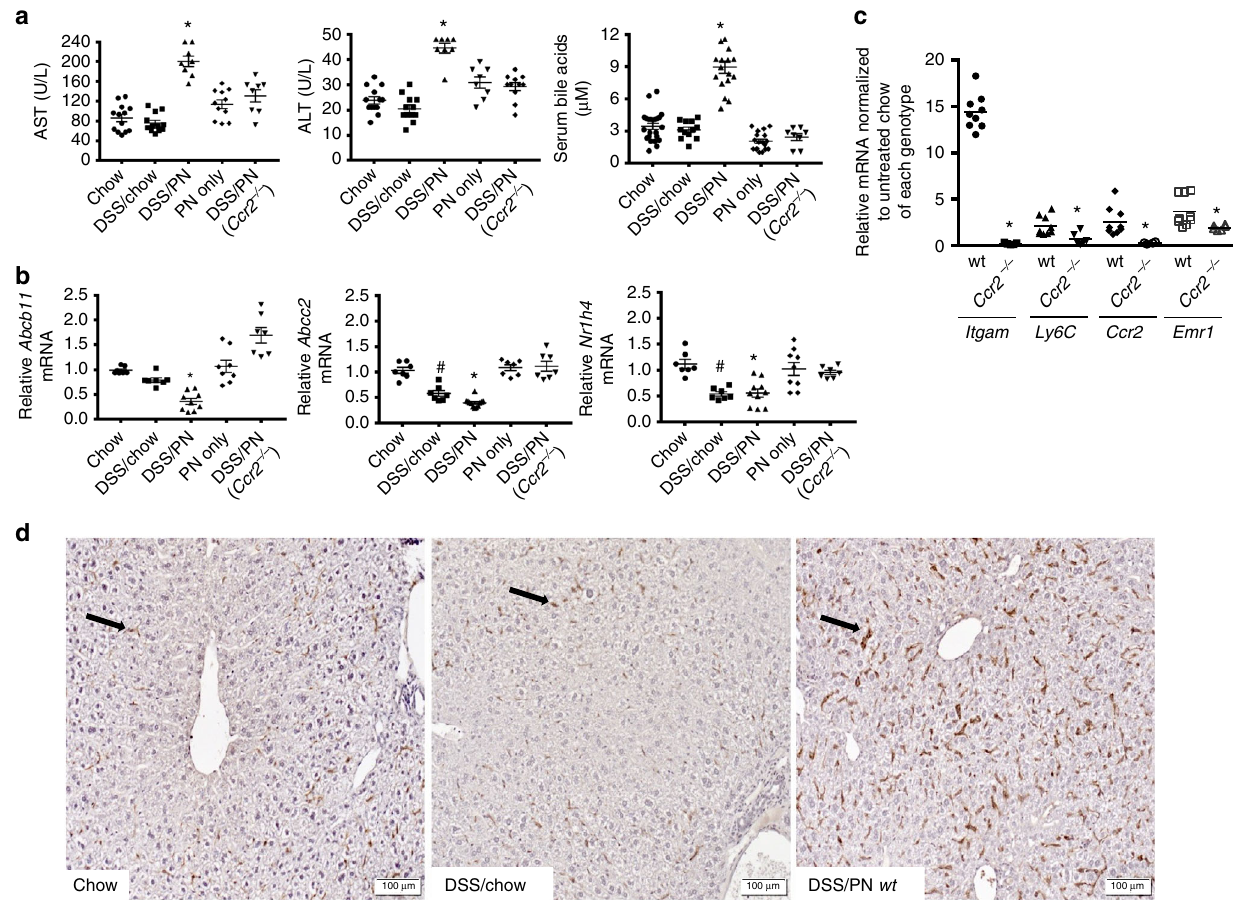
Fig. 1 Mice with genetic Ccr2 de fi ciency are protected from PNAC. a Peripheral serum aspartate-aminotransferase (AST), alanine-aminotransferase (ALT), and total bile acid concentrations in completely unmanipulated mice (chow), DSS-pretreated mice without any further manipulation, (DSS/chow) wild-type (WT) DSS-pretreated mice infused with PN (DSS/PN), PN infused wild-type mice without DSS pretreatment (PN only), and Ccr2 − / − DSS-pretreated mice infused with PN ( Ccr2 − / − DSS/PN). b Liver mRNA from the same groups of mice as in a of genes encoding BSEP ( Abcb11 ), MRP2 ( Abcc2 ), and FXR ( Nr1h4 ) and c liver mRNA from DSS/PN WT and Ccr2 − / − mice of genes encoding CD11b ( Itgam ), Ly6C, CCR2, and F4/80 ( Emr1 ). d Representative liver immunohistochemistry for F4/80 from chow, DSS/chow, and DSS/PN mice (black arrows point to F4/80 + cells). * p < 0.05 vs. all other groups by one- way ANOVA and Tukey's correction ( a and c ). * p < 0.05 vs. chow, PN only, Ccr2 − / − DSS/PN; # p < 0.05 vs. chow by one-way ANOVA and Tukey's correction ( b ). Data are depicted from individual mice for serum analysis and means from PCR triplicates from individual mice for gene expression data